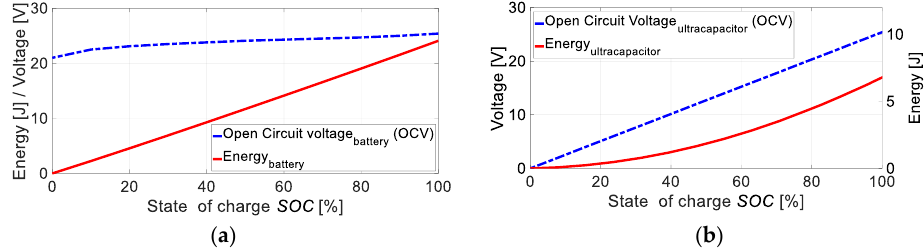
Figure 2. Plots of the open circuit voltage ( OCV ) = f ( SOC ) and the stored energy as the function of state of charge for: ( a ) battery; ( b ) ultracapacitor.